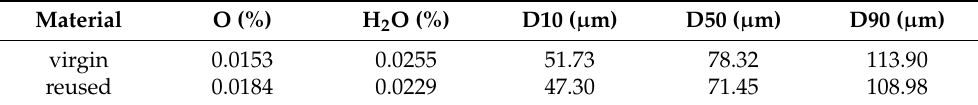
Table 2. Nitrogen and oxygen content determined by inert gas fusion and moisture measured by thermogravimetry